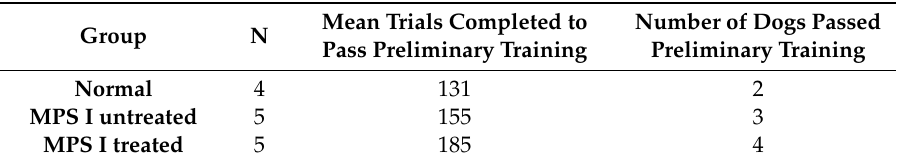
Table 17. Preliminary training for scent discrimination by group. This includes the number of dogs tested (N) from each group, mean (real) number of trials completed to pass training, and the number of dogs that successfully completed preliminary training from each group.